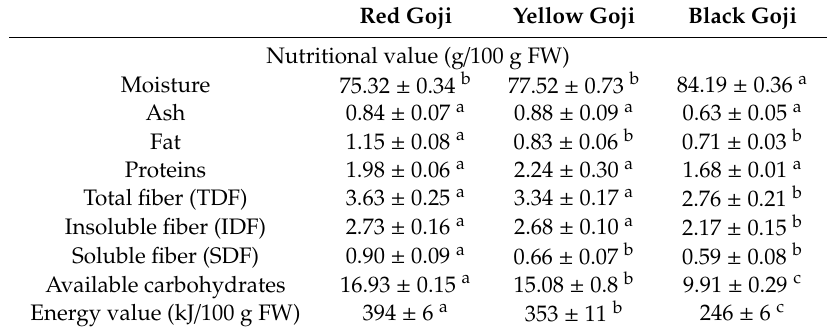
Table 1. Nutritional composition and energy value of the studied goji berry fruits (mean ± SD; n =